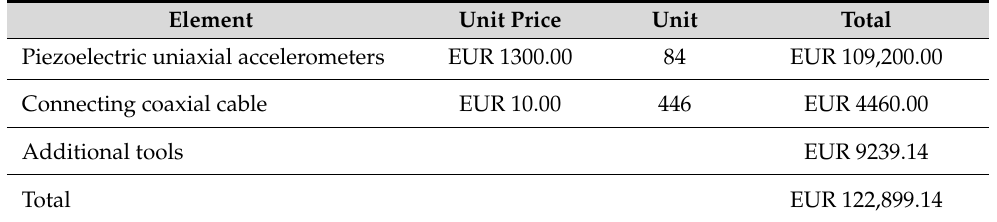
Table 11. General costs for a SHM system on Magliana bridge using Piezoelectric accelerometers. Element